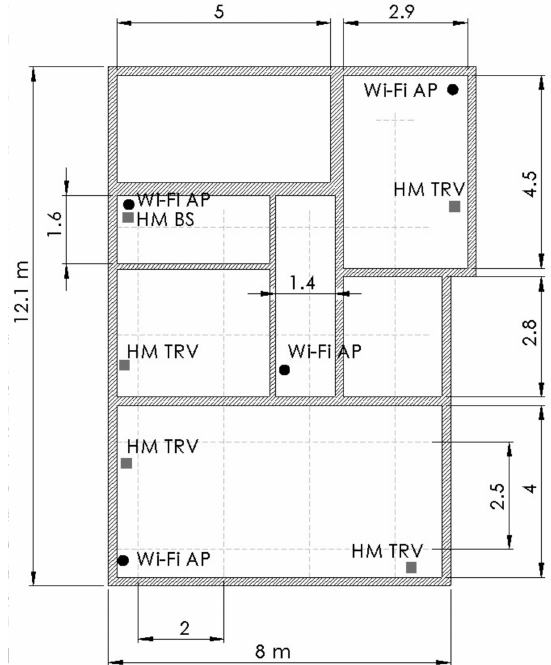
Figure 2. Evaluation environment with marked positions of Wi-Fi access points (Wi-Fi AP), HomeMatic thermostatic valves (HM TRV) and HomeMatic base station/gateway (HM BS). Evaluations points are marked by crossings of dashed gray lines; unit of length is meter